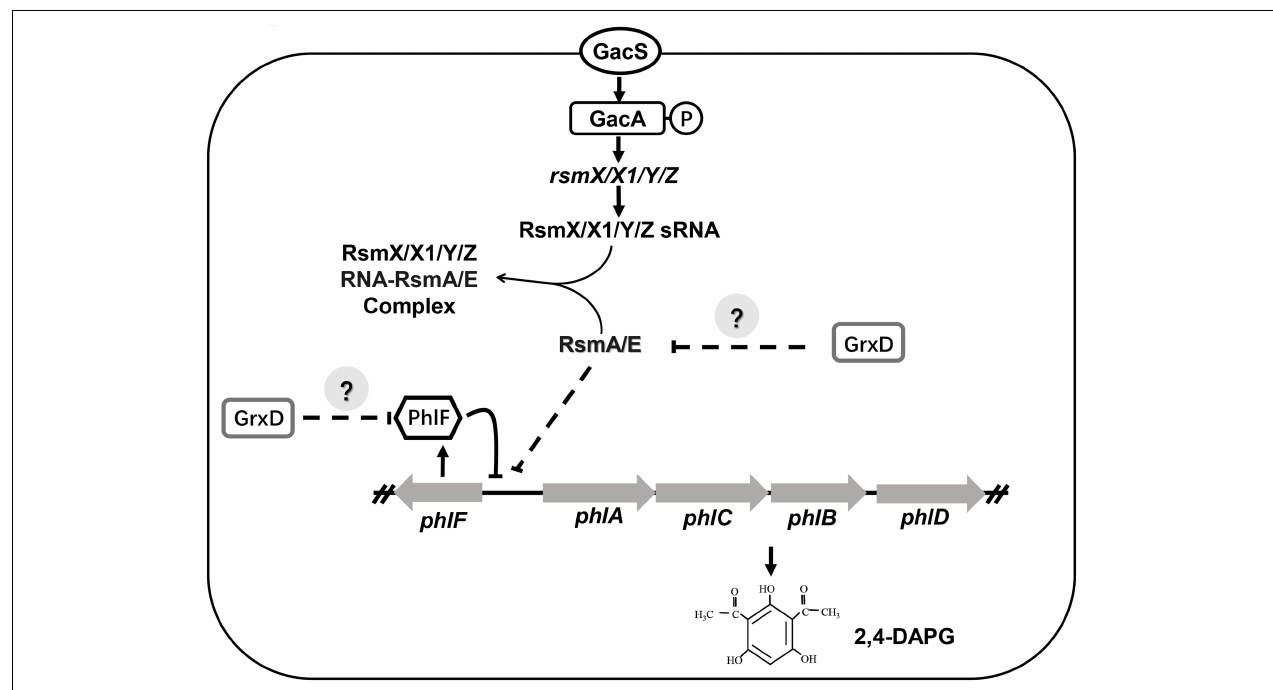
FIGURE 9 | Model of GrxD affects the production of 2,4-DAPG in Pseudomonas fluorescens 3P24. The production of 2,4-diacetylphloroglucinol (2,4-DAPG) was previously reported to be regulated by the Gac/Rsm signaling pathway and the transcriptional factor PhlF. In this study, the levels of RsmA/E and PhlF proteins were modulated by GrxD. In addition, GrxD could interact directly with an unknown transcriptional regulator, which may influence the expression of rsmA/E and phlF .